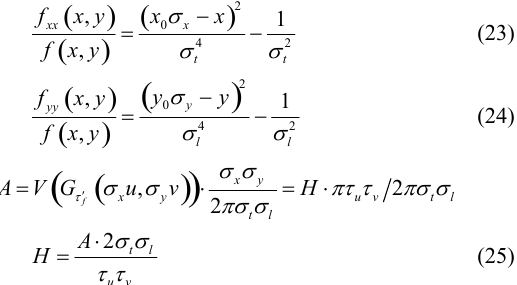
)MaskRange (d)FFT Contour Synthesized Sinc Peak with Gauss(  t=  l=4